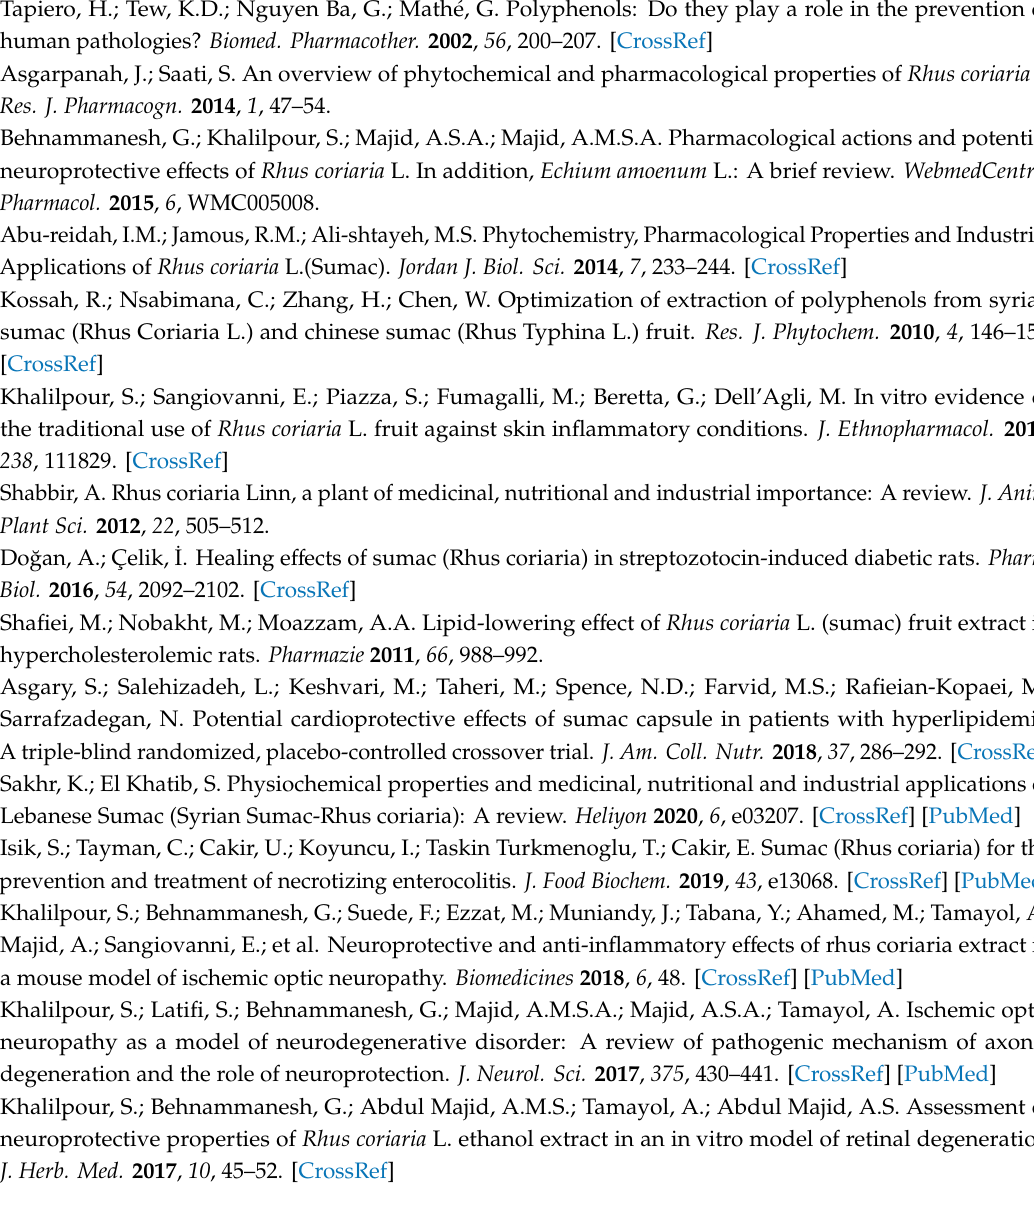
Table S1: Cellular viability used for normalization of cellular antioxidant activity values, measured through MTT assay. Figure S1: Intracellular ROS presence: (a) C20, (b) T20, (c) E25 + T20. Fluorescence microscopy, obj. 100X oil, DAPI staining for cellular nuclei, FITC staining for ROS. Figure S2: Alkaline Comet assay: (a) C20, (b) T20, (c) E25 + T20. Fluorescence microscopy, obj. 40X oil, propidium iodide staining. Figure S3: FACS report of cellular population in Annexin V assay. (a) C25, (b) T25, (c) E25 + T25. For each image: Q3-1 represents the necrotic population, Q3-2 and Q3-4 represent the apoptotic population, Q3-3 represents the living